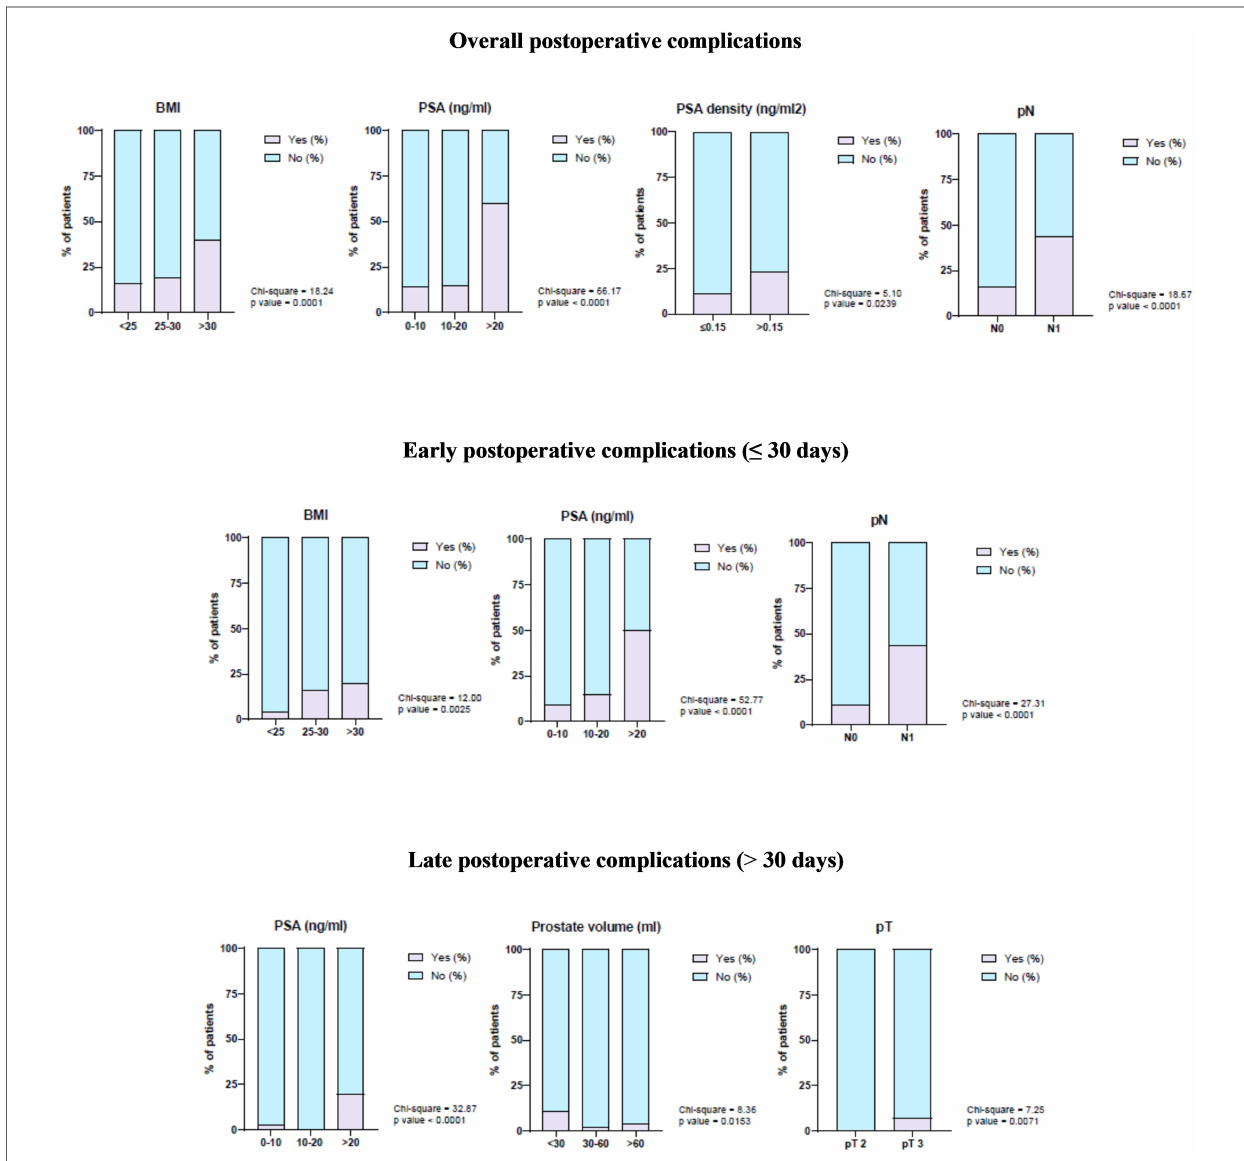
FIGURE 1 Correlation of demographic and clinical – pathological characteristics with overall postoperative complications, early postoperative complications, and late postoperative